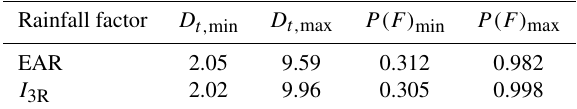
Table 7. Intervals of instability index and landslide probability of rainfall factors.